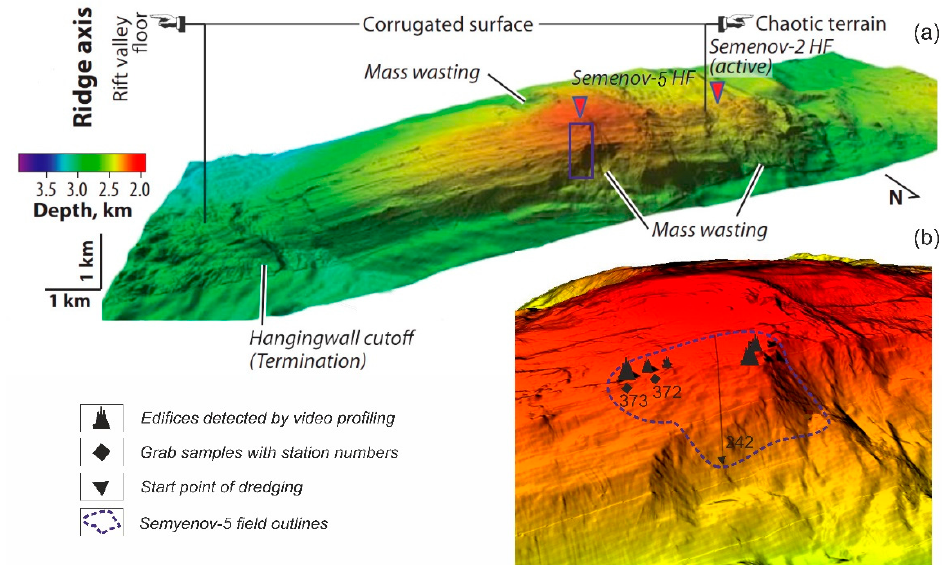
Figure 2. The 13°30 ′ N OCC detachment surface. ( a ) Three ‐ dimensional views of the 13°30 ′ N OCC microbathymetry showing the different structural domains together with other morphologic features according to ODEMAR data [20]. The box corresponds to the area of ( b ). ( b ) Location of the Semenov 5 field at the northern slope of OCC and position of TV ‐ Grab and dredge stations. Field outlines are determined by video profiling [12,13].